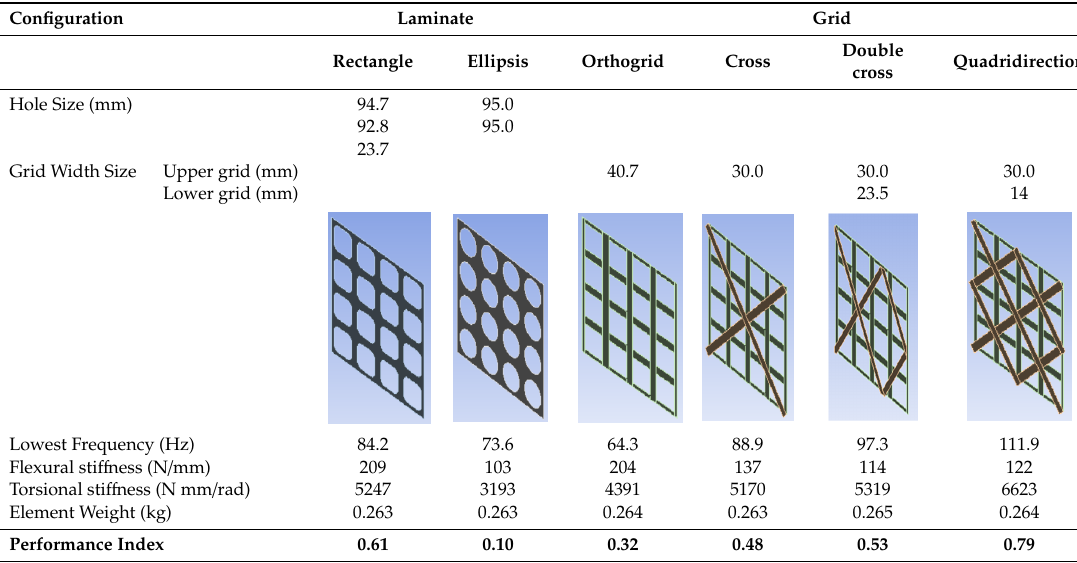
Table 5. E ff ect of changes in geometry (at the level of basic element). Table 5. Effect of changes in geometry (at the level of basic element). Table 5. Effect of changes in geometry (at the level of basic element). Table 5. Effect of changes in geometry (at the level of basic element). Table 5. Effect of changes in geometry (at the level of basic element). Table 5. Effect of changes in geometry (at the level of basic element). Table 5. Effect of changes in geometry (at the level of basic